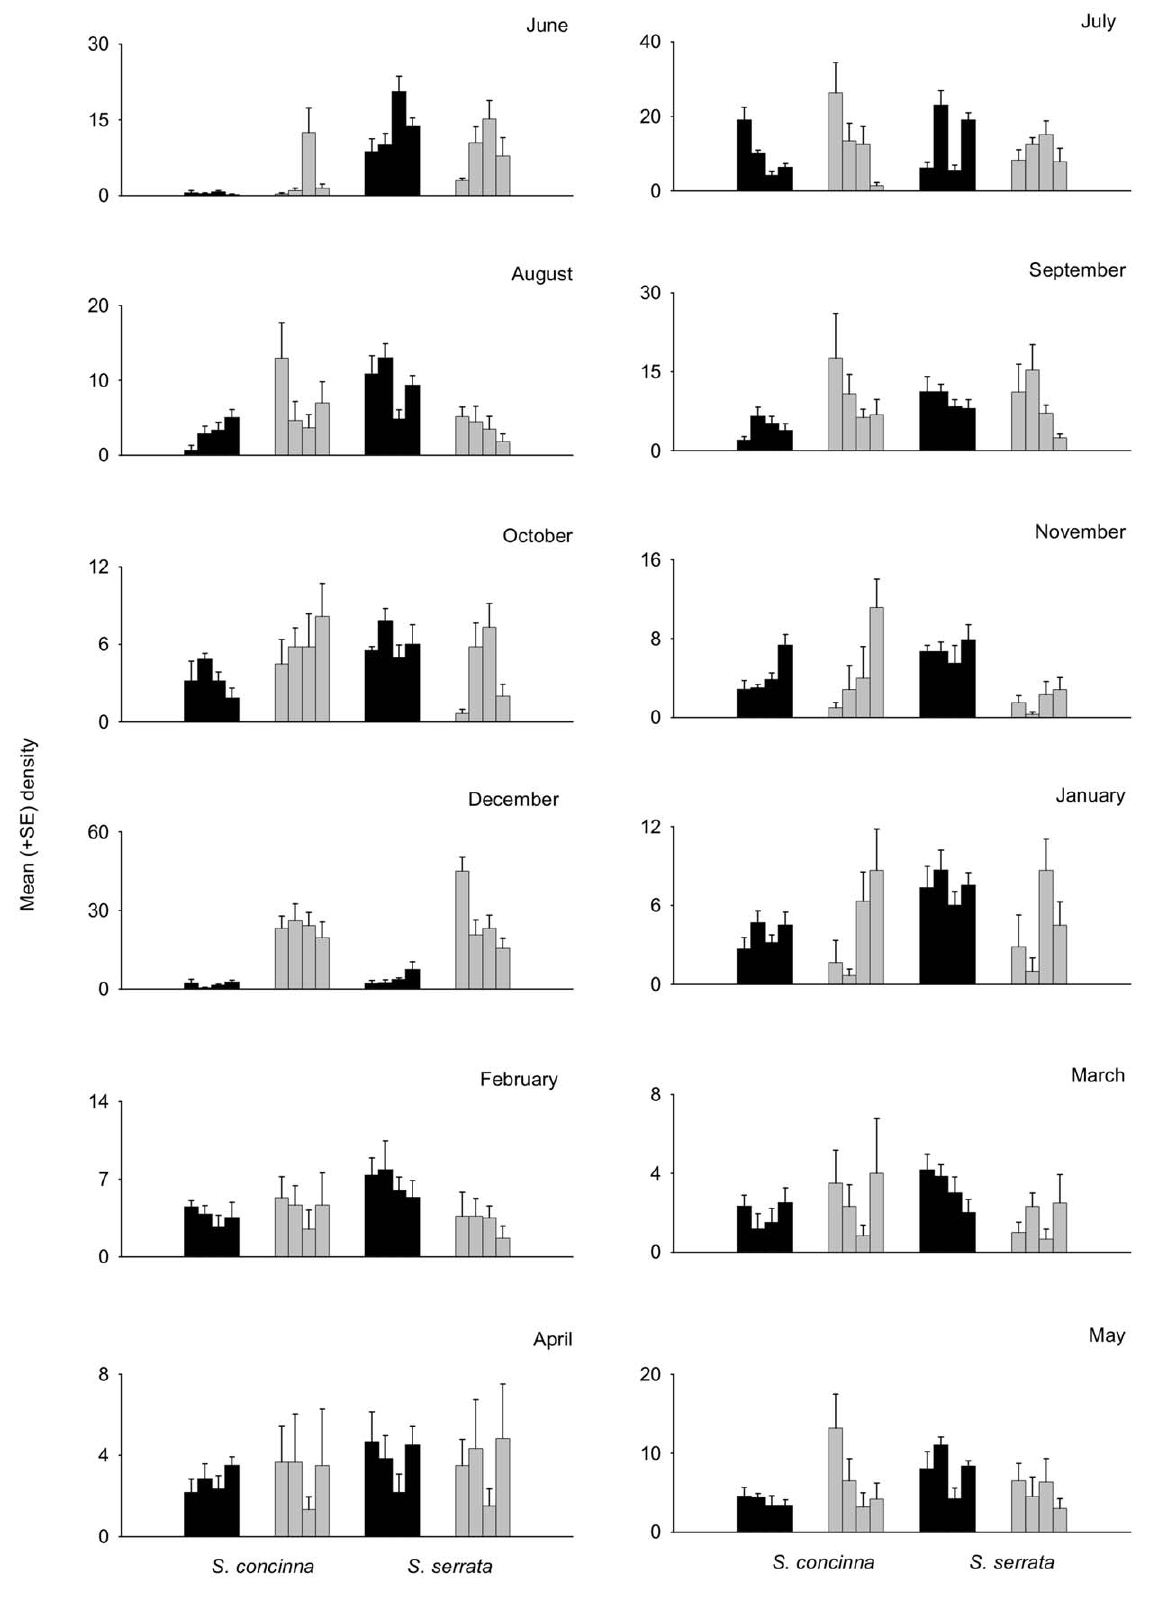
Figure 4. Mean ( + SE; n =6) density of adult Siphonariaconcinna and S.concinna in small (black bars) or large patches (grey bars) in the Eastern Cape each month from June 2009 to May 2010.